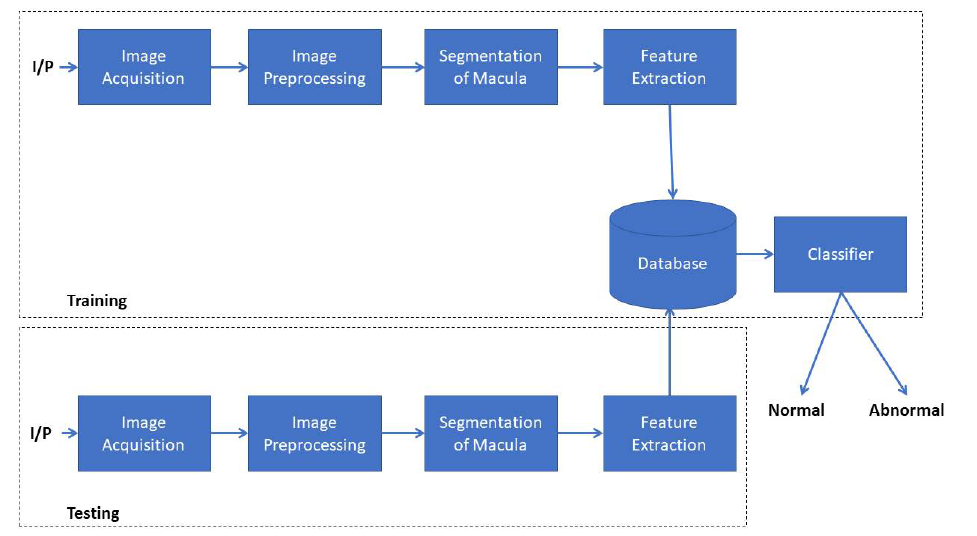
Figure 6. Block diagram of the Overall System for Retinal Abnormality detection